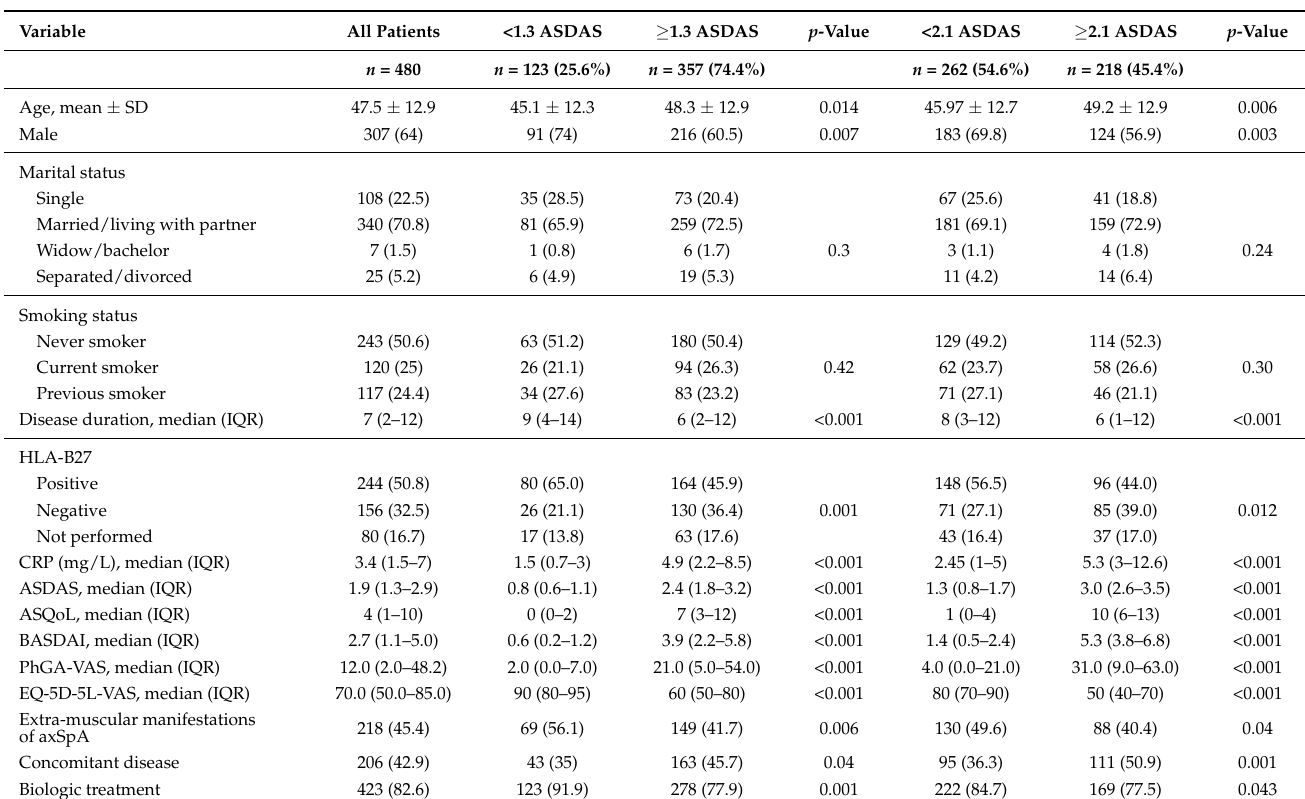
Table 1. Demographics and baseline clinical characteristics of all evaluable patients stratified by the ASDAS cut-off